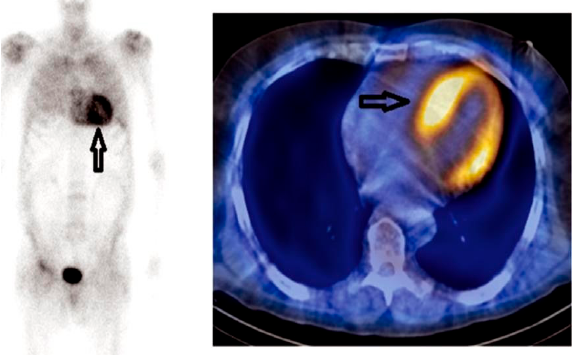
Figure 5. A positive 99m Tc-DPD scan for TTR cardiac amyloid (left) showing uptake in the heart (arrow) and reduced bone uptake. The right-hand panel shows a fused CT/SPECT image showing myocardial uptake, with greater uptake in the septum.